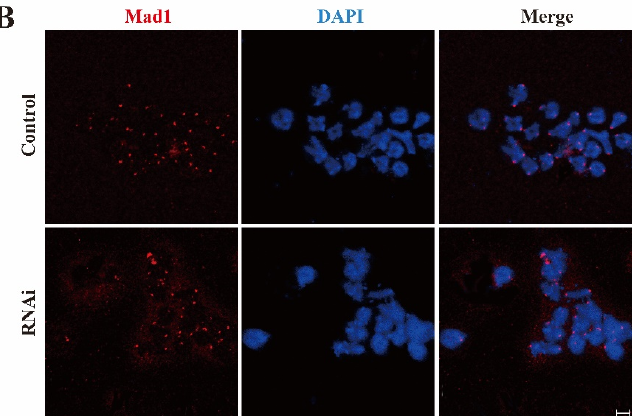
Figure 5. The location of BubR1 and Mad1 was not affected in the Rae1 knockdown oocytes. After Rae1 knockdown, GV stage oocytes were cultured for 8.5 h and then collected for immunofluorescent staining of BubR1 and Mad1. ( A ) Confocal image of BubR1 localization in the control and Rae1 knockdown oocytes by chromosome spreading. BubR1 is shown in green and DAPI in blue. Scale Bar = 5 μm. ( B ) Confocal image of Mad1 localization in the control and Rae1 knockdown oocytes by chromosome spreading. Mad1 is shown in red and DAPI in blue. Scale Bar = 5 μm. 2.6. Rae1 Depletion Decreases the Protein Level of securin but Not Cyclin B Anaphase-promoting complex or cyclosome (APC/C) directly controls the meta- phase–anaphase transition by regulating the proper degradation of securin and cyclin B [21]. In this experiment, we assessed the protein levels of securin and cyclin B in the con- trol and Rae1 knockdown oocytes at the MI stage. As shown in Figure 6, the protein level of securin was significantly decreased in the Rae1 knockdown oocytes; however, the pro- tein levels of both cyclin B1 and cyclin B2 were similar between the control oocytes and the Rae1 knockdown oocytes, which indicated that Rae1 specifically modulates the pro- tein level of securin.